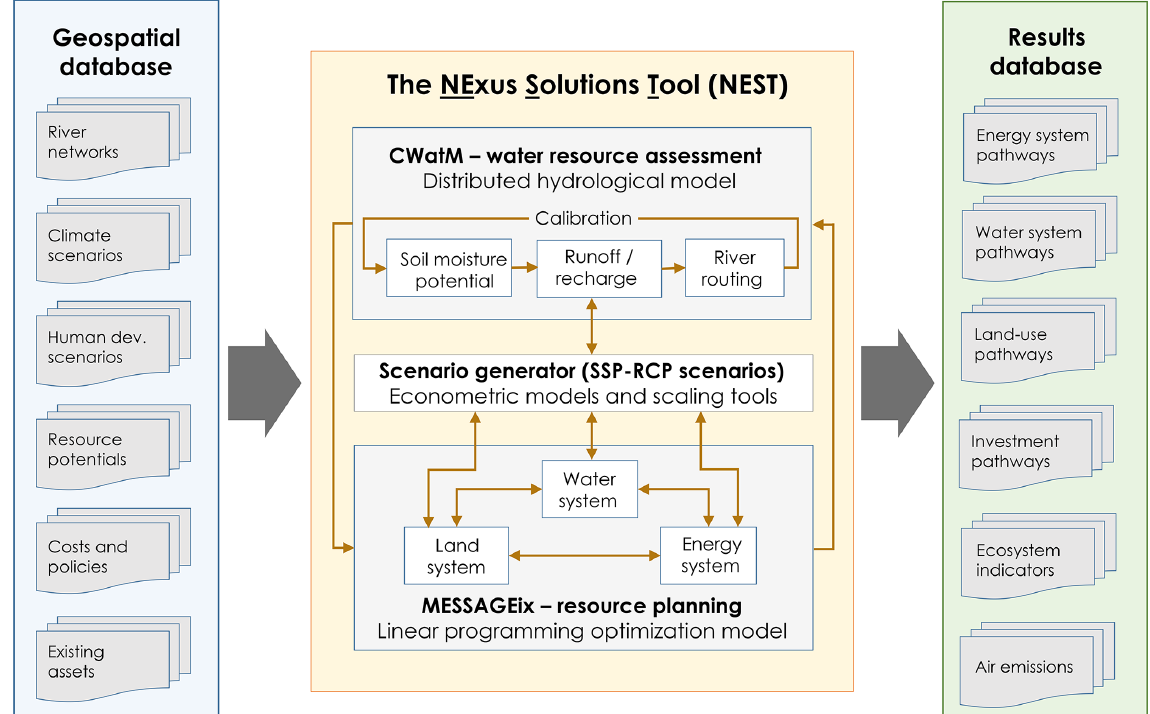
Figure 1. The NEST modeling scheme integrates the Community Water Model (CWatM) with a unified EWL technological system im- plemented in MESSAGEix. A scenario generator harmonizes data across the models and generates exogenous demand profiles aligned with coupled climate–human development narratives from the Shared Socioeconomic Pathways (SSPs) and Representative Concentration Pathways